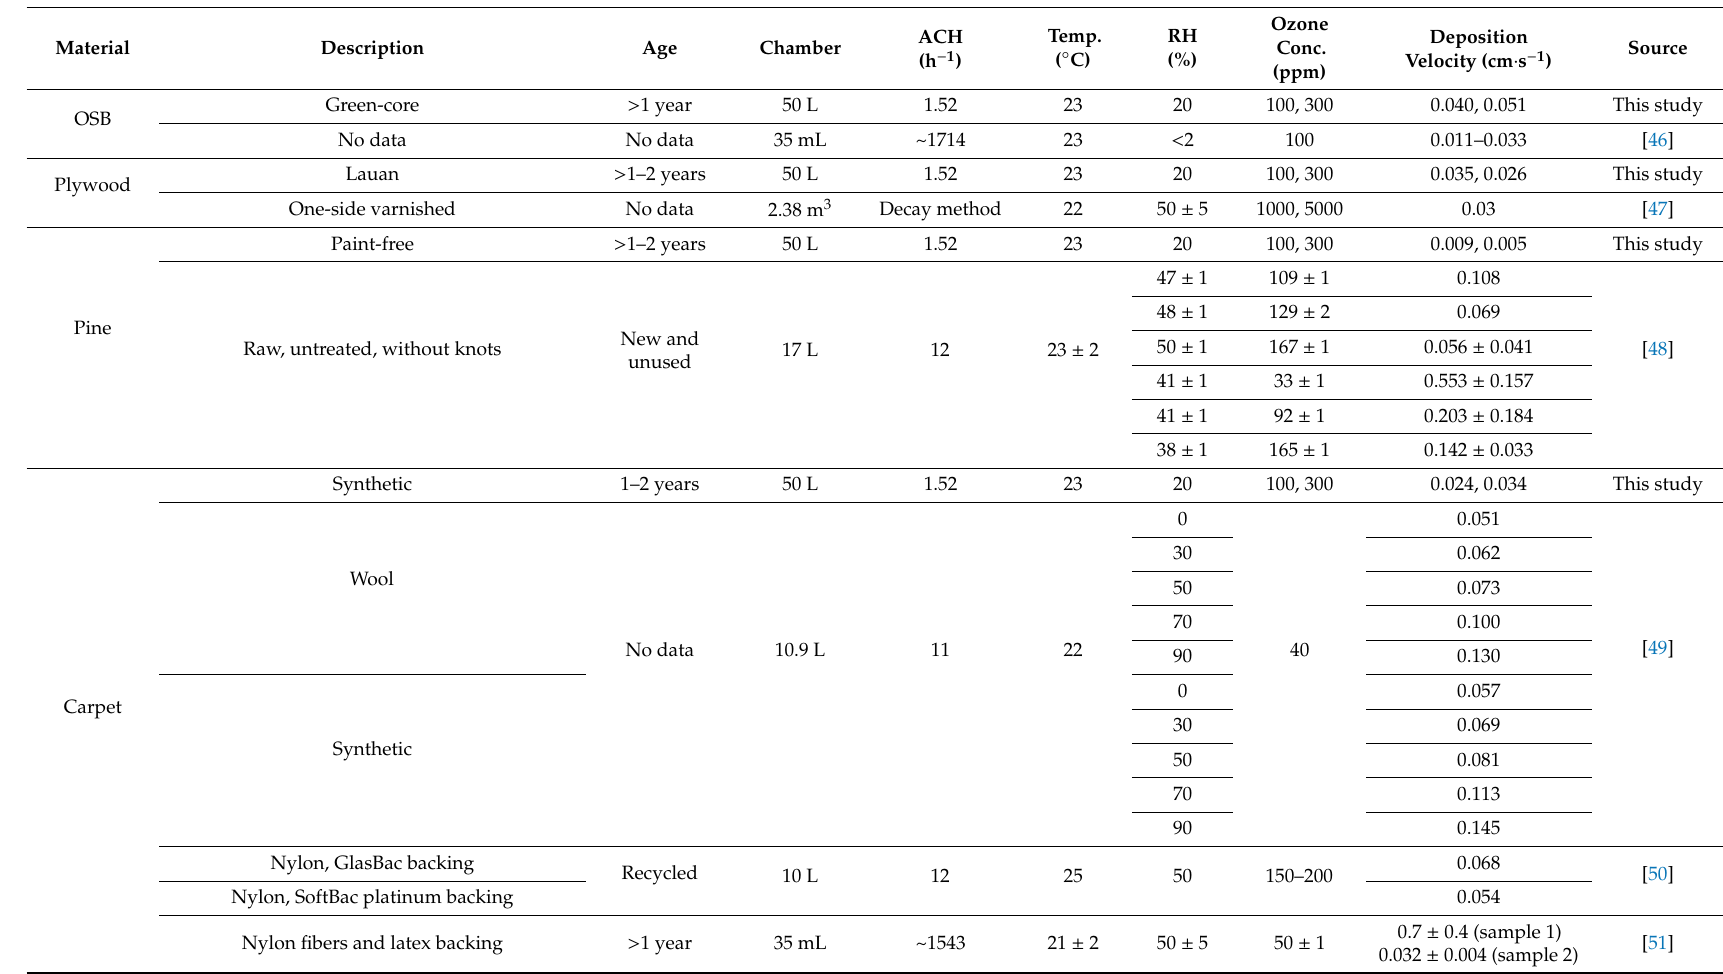
Table 6. Comparison of ozone depositions measured in this study and the data from the